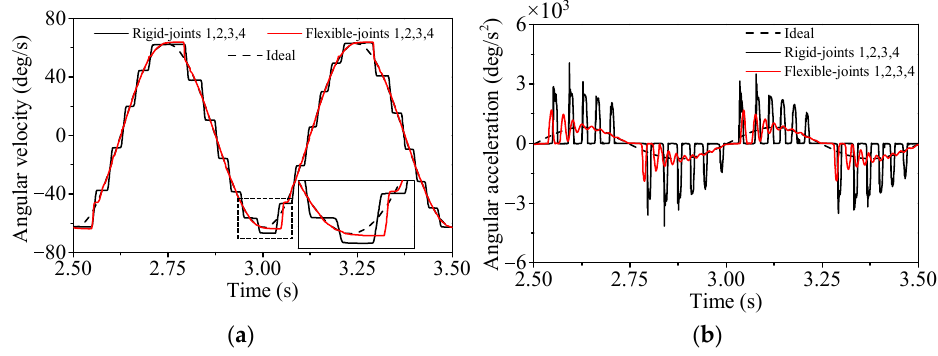
Figure 22. Effects of clearances at joints 1, 2, 3, and 4 when considering the flexibility of the auxiliary rod: ( a ) angular velocity; ( b ) angular acceleration.